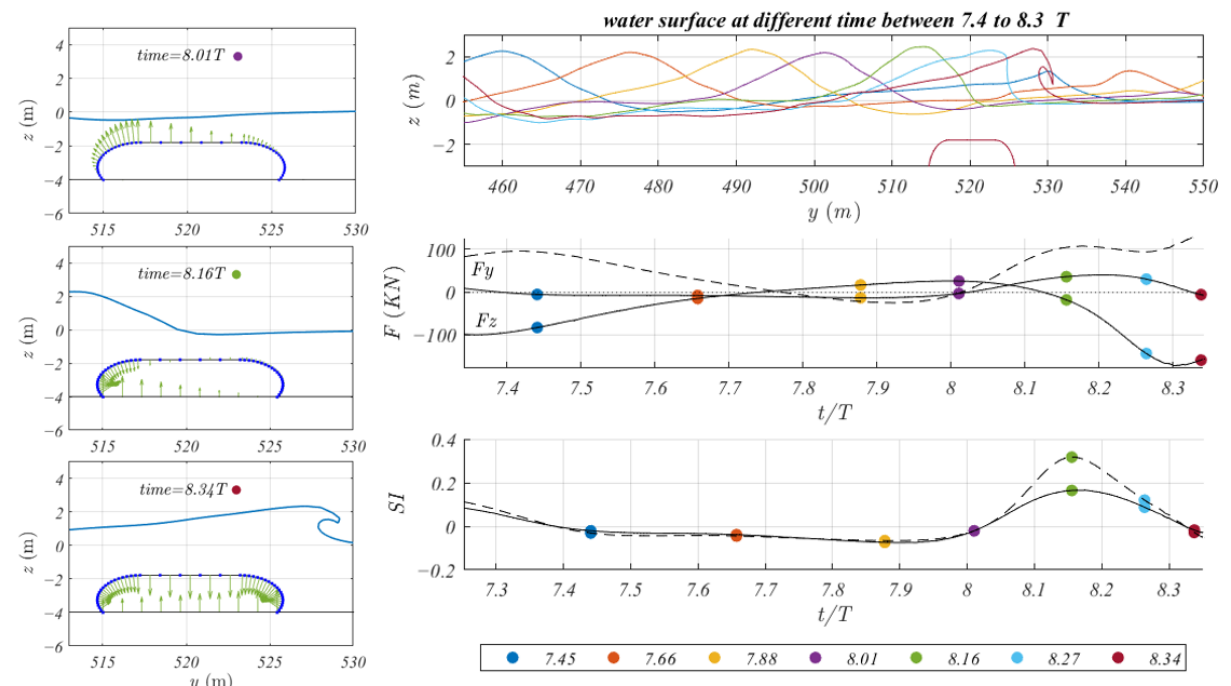
Figure 11. Left: Diagrams of the dynamic pressure acting on the Geotube during the wave breaking. Right: water surface elevations, loads and SI for a practical design example. T = 9 s, wave height at the wave generator = 2.2 m .